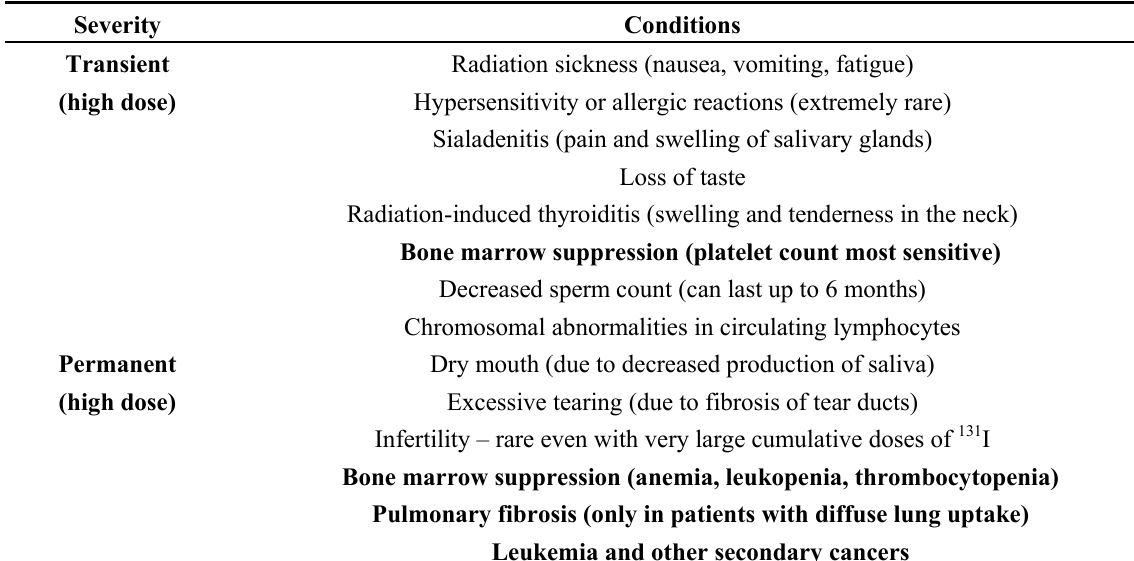
Table 8. Adverse Reactions to high dose 131 I